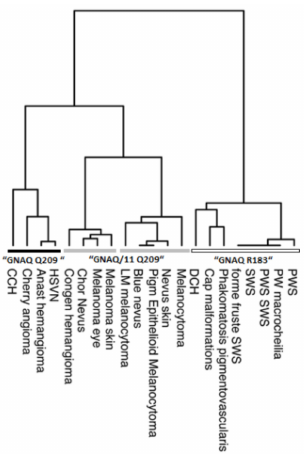
Figure 5. Unsupervised hierarchial cluster analysis of the GNAQ / GNA11 mutation profile in different tumor entities. Four main clusters are formed which are named after the predominant mutation. Analysis is based on data presented in this paper and elsewhere (see Supplementary Materials Table